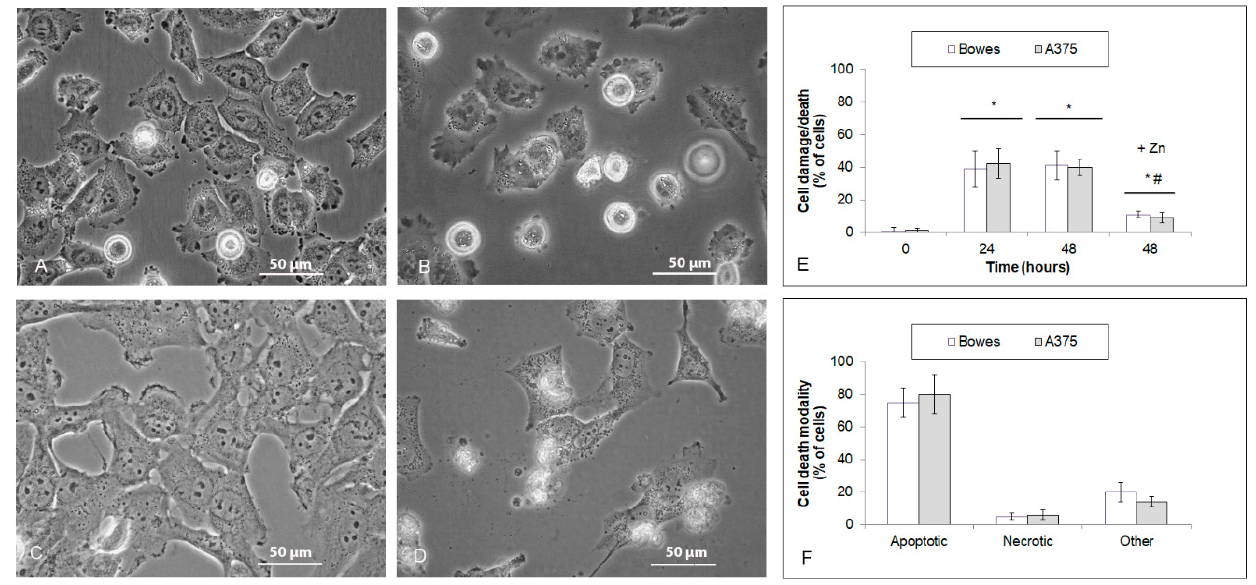
Figure 5. Cell damage/death of human melanoma cells Bowes and A375 exposed to 25 µM TPEN during 48 h. Cells were treated with TPEN alone or with zinc sulfate (100 µM) and their effect on cell damage/death was evaluated by morphometric analysis of cell micrographs obtained from time-lapse microscopy ( A – E ) and propidium iodide ( F ). Results represent means ± SD of four experiments. ( A – D ) Phase contrast microscopy, 600×. ( E ) p < 0.05 * Significantly higher compared to the beginning of treatment, p < 0.05 # Significantly lower than TPEN only treated cells at 48 h with one-way-Anova test and Dunnett’s post test for multiple comparisons.